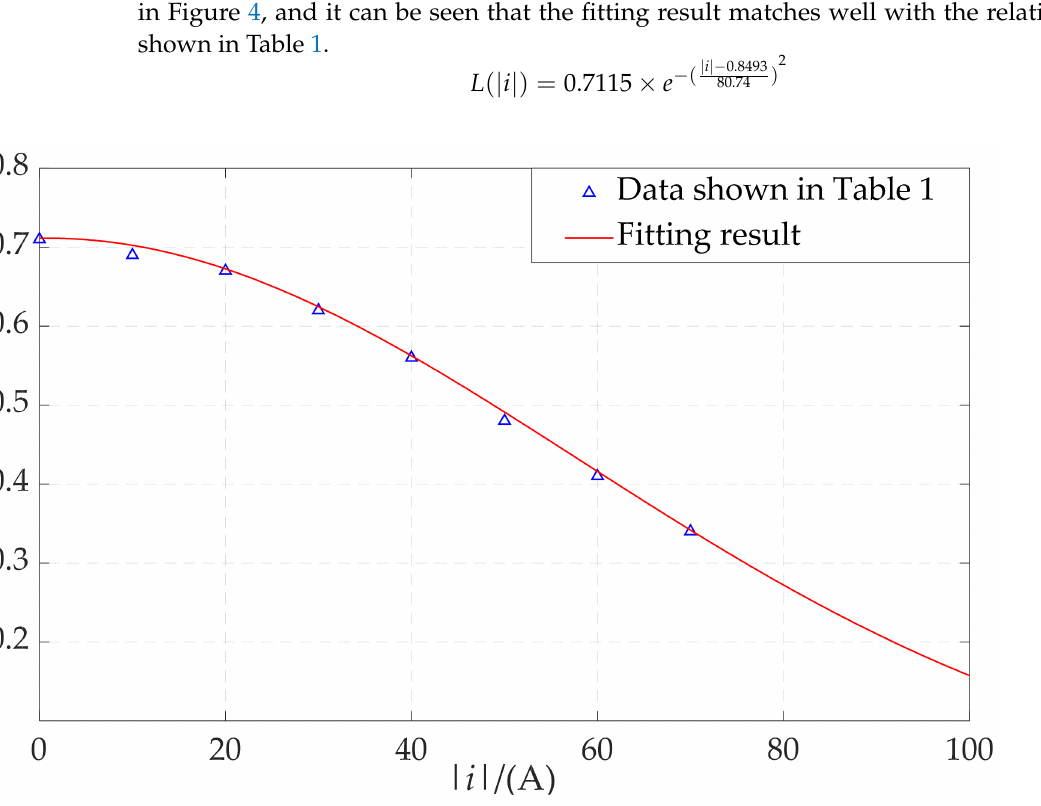
Figure 4. Fitting result of the filter inductance